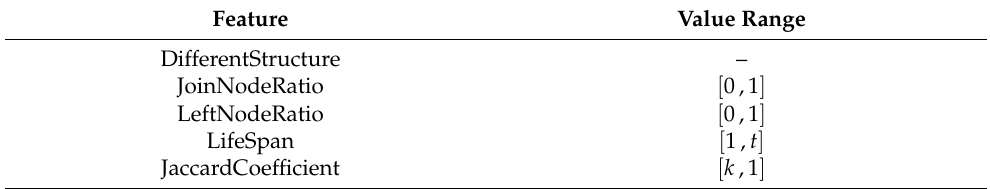
Table 3. Community Sequential